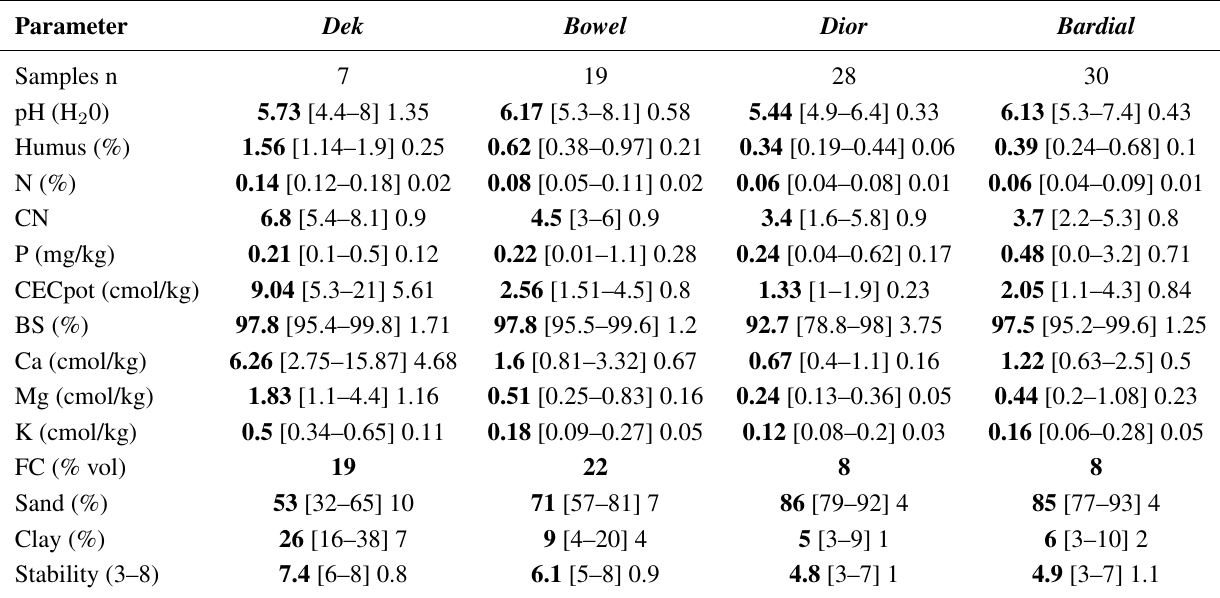
field and laboratory measurements. Mean value , range [min–max] and standard deviation are provided.